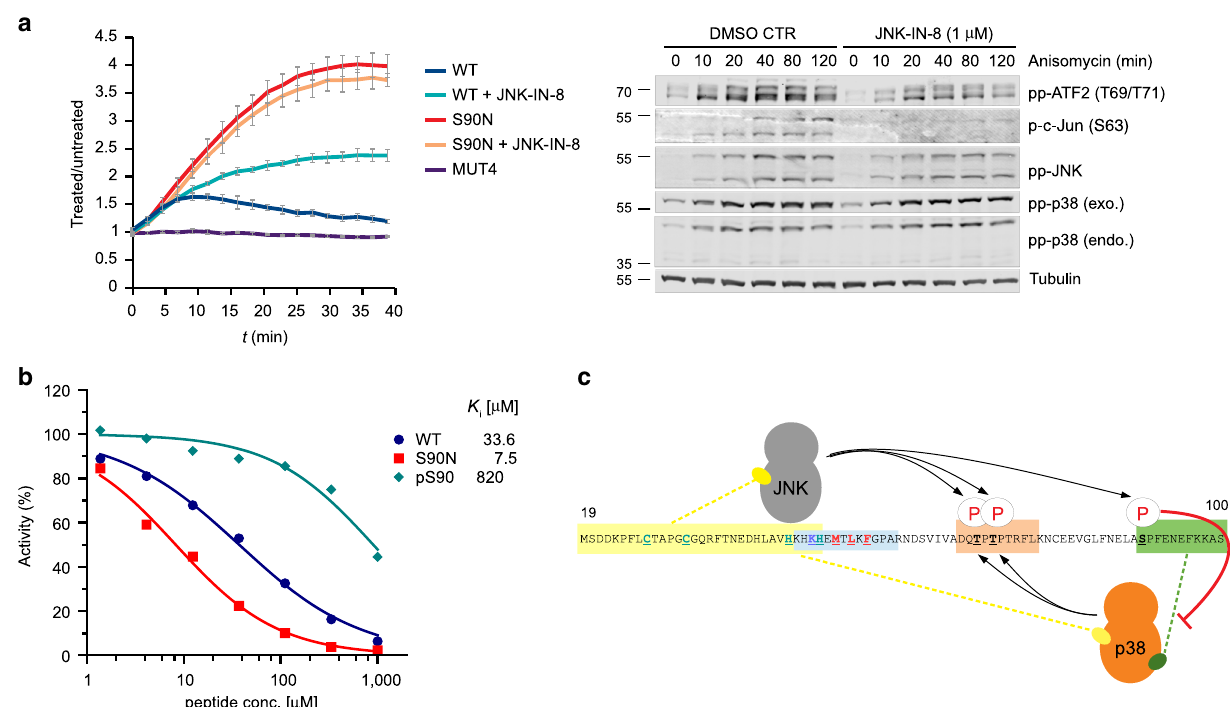
Fig. 4 JNK mediated phosphorylation affects p38-ATF2 TAD binding. a p38-ATF2 TAD binary interaction after anisomycin treatment. Binding was monitored in time after the addition of anisomycin using a luciferase complementation based protein – protein binding assay (NanoBit) in live cells (left panel). Anisomycin treatment turns on p38 and JNK pathway activity in HEK293T cells (pp-p38 or pp-JNK — or p-c-Jun — western-blot signal, respectively; right panel; min — minutes). Wild-type (WT), S90N, and FENEF region mutated (MUT4) TAD constructs interacted with the p38 luciferase probe differently after turning on p38 phosphorylation by anisomycin (10 µ g/mL). Luminescence signal was normalized to cells not treated by anisomycin (treated/untreated). The panel on the right shows results of western-blots with different antibodies; exo: luciferase fragment tagged exogenous p38 probe; endo: endogenous p38; tubulin: anti-tubulin antibody used as the load control. DMSO CTR: cells treated only by anisomycin. JNK-IN-8: cells treated with anisomycin and a JNK-speci fi c inhibitor. MAPK mediated ATF2 TAD phosphorylation at the phosphoswitch was monitored with the pp-ATF2(T69/71) antibody. Error bars show SD from three technical replicates. Data are represented as mean values± SD. The experiment was repeated twice with similar results. b Inhibition of pp-p38 mediated TAD phosphorylation by SPFENEF motif-containing peptides in vitro. WT, S90N and S90 phosphorylated (pS90) peptides (83 – 102) were added in increasing amounts to an in vitro pp-p38 → TAD(19 – 100) phosphorylation reaction. The Ki values for the three peptides are highlighted. c Schematic of MAPK binding to different ATF2 TAD regions and phosphorylation of critical S/TP sites. Source data are provided as a Source data fi